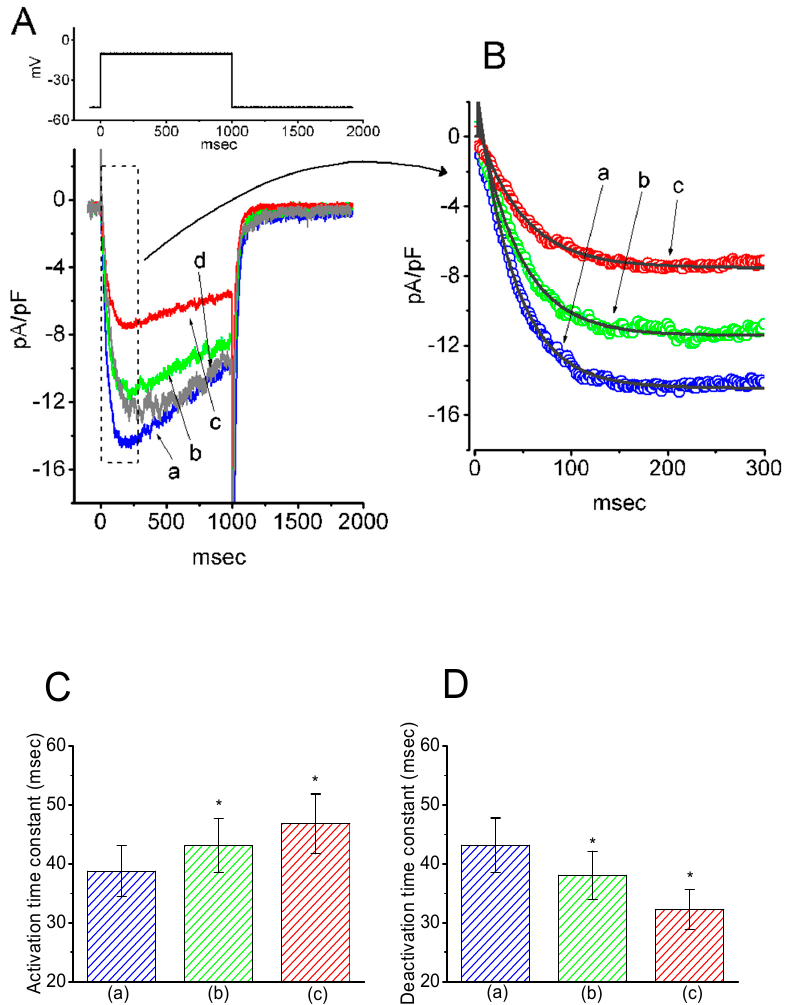
Figure 1. Inhibitory e ff ect of gastrodigenin (HBA) on I K(M) density recorded from pituitary GH 3 cells. As the whole-cell mode was established, the examined cell was depolarized from − 50 to − 10 mV for 1 s, as indicated in the upper part of (A). ( A ) Original traces of I K(M) density obtained with or without the addition of HBA. (a) control; (b) 3 µ M HBA; (c) 10 µ M HBA; (d) washout of 10 µ M HBA. ( B ) Expanded record from the dashed box in (A), indicating the e ff ect of HBA on the activation time course of the I K(M) -density trajectory elicited by membrane depolarization. The data points (open circles) were reduced by a factor of 10 for clarity. Each current trajectory was least-squares fitted by a single exponential (indicated by the smooth line) with activation time constants ( τ act ) of 38.8 ms (a) in the absence of HBA, 43.0 ms (b) in 3 µ M HBA, and 46.8 ms (c) in 10 µ M HBA. ( C ) and ( D ) illustrate the summary bar graphs showing the e ff ects of HBA on the τ act and τ deact values of I K(M) -density trajectory, respectively (mean ± SEM; n = 11 for each bar). * p < 0.05 vs.